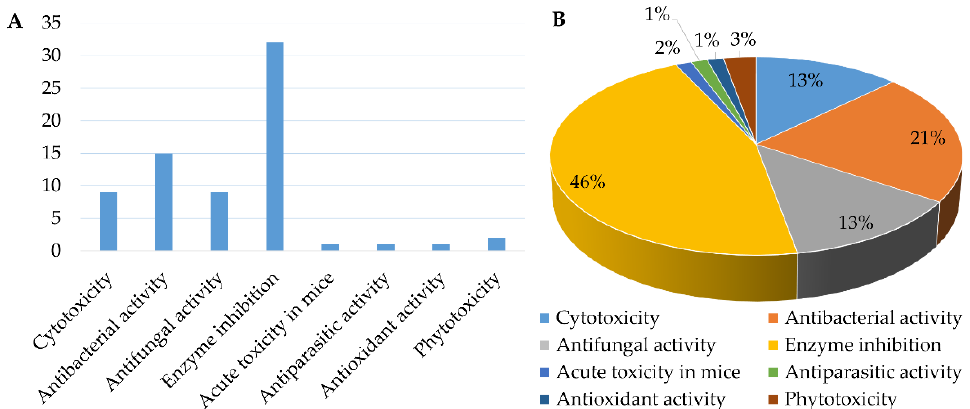
Figure 14. Bioactivities of natural products isolated from Chrysosporium from 1984 to 2021.